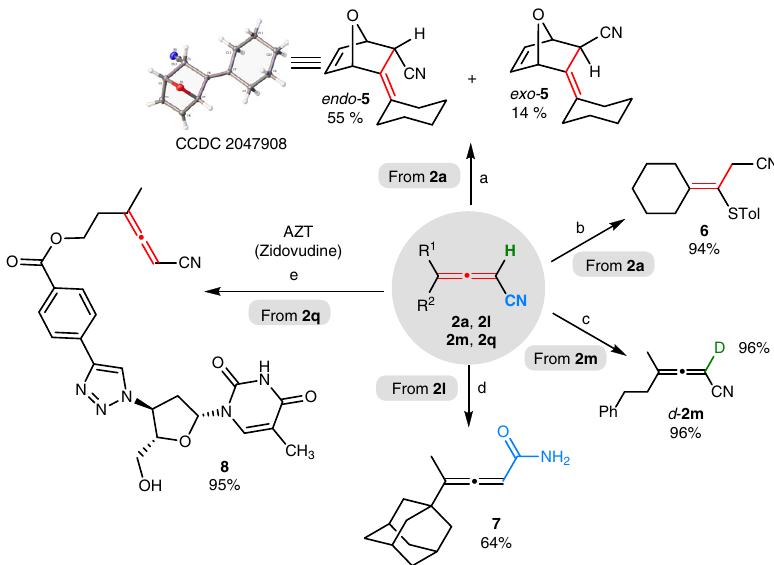
Fig. 4 Synthetic transformations of allenenitriles. Reagents and conditions: (a) 2a (0.2 mmol), Cu(CH 3 CN) 4 BF 4 (20 mol%), freshly distilled furan (2 mL), 50 °C, 2 d; (b) 2a (0.4 mmol), 4-methylbenzenethiol (1.2 equiv), Et 3 N (2.0 equiv), CHCl 3 , rt, 24 h; (c) 2 m (0.27 mmol), K 2 CO 3 (5.0 equiv), n -Bu 4 NBr (1.0 equiv), Toluene/D 2 O = 9:11, rt, 2.5 d; (d) 2 l (0.2 mmol), NaOH (20 mol%), Na 2 CO 3 (1.0 equiv), H 2 O 2 (3.9 equiv), EtOH/H 2 O = 5:1, rt, 24 h; (e)